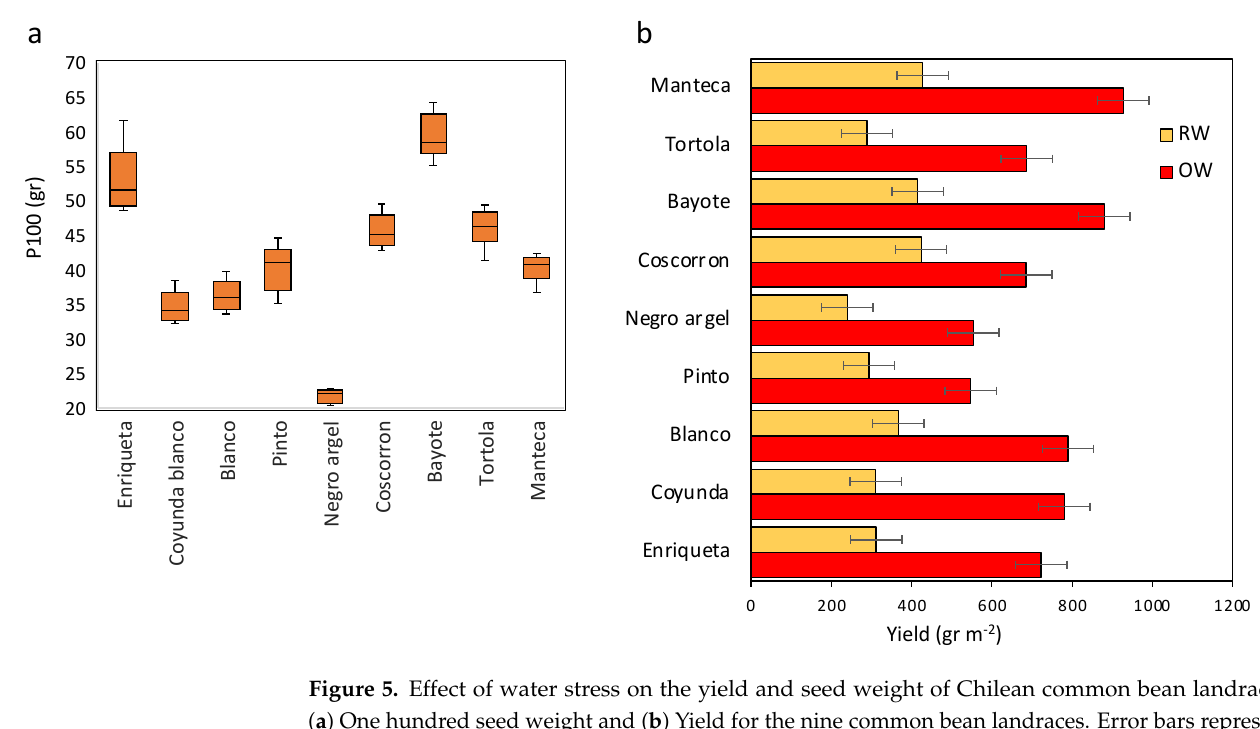
Figure 5. Effect of water stress on the yield and seed weight of Chilean common bean landraces. ( a ) One hundred seed weight and ( b ) Yield for the nine common bean landraces. Error bars represent least significant differences (LSD) value of the interaction water conditions by varieties at p < 0.05. Table 1. Effect of water stress on the traits Pod N ◦ , Seed N ◦ , Seed by pod, and Pod harvest index